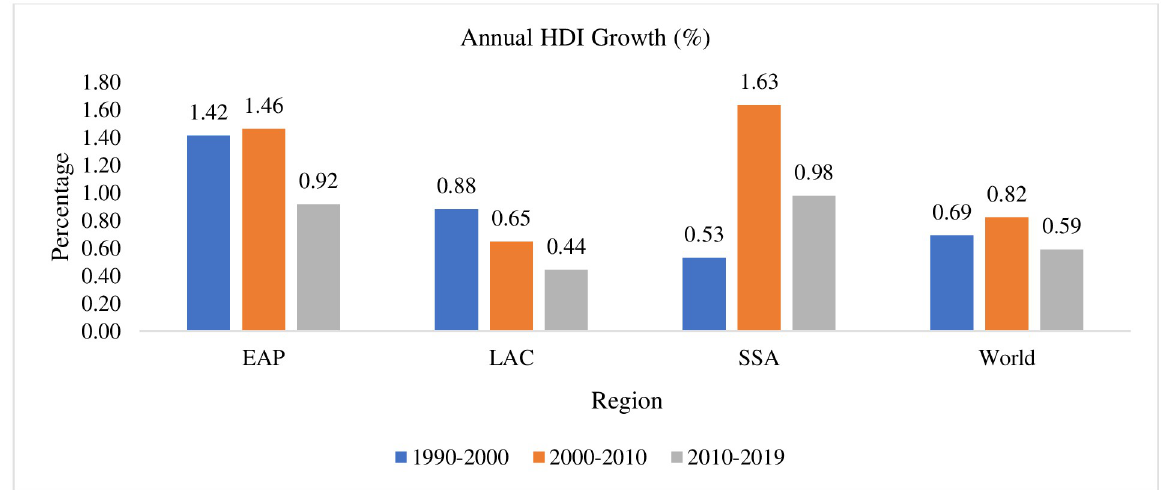
Fig 4. Annual HDI growth (%). Source: Researchers’ Compilation, using human development index.